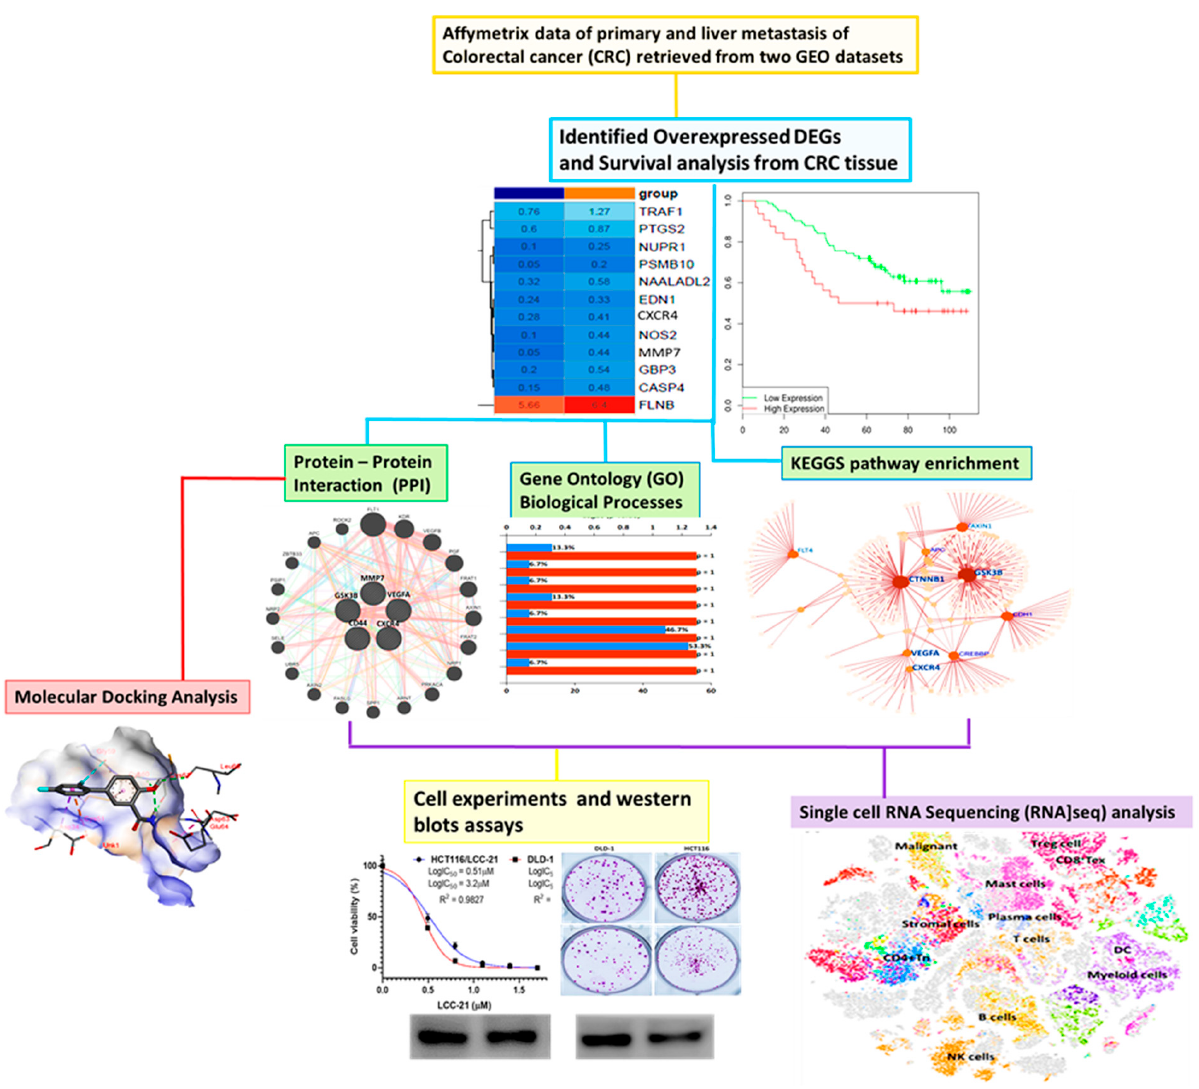
Figure 1. Schematic diagram representing the study design.